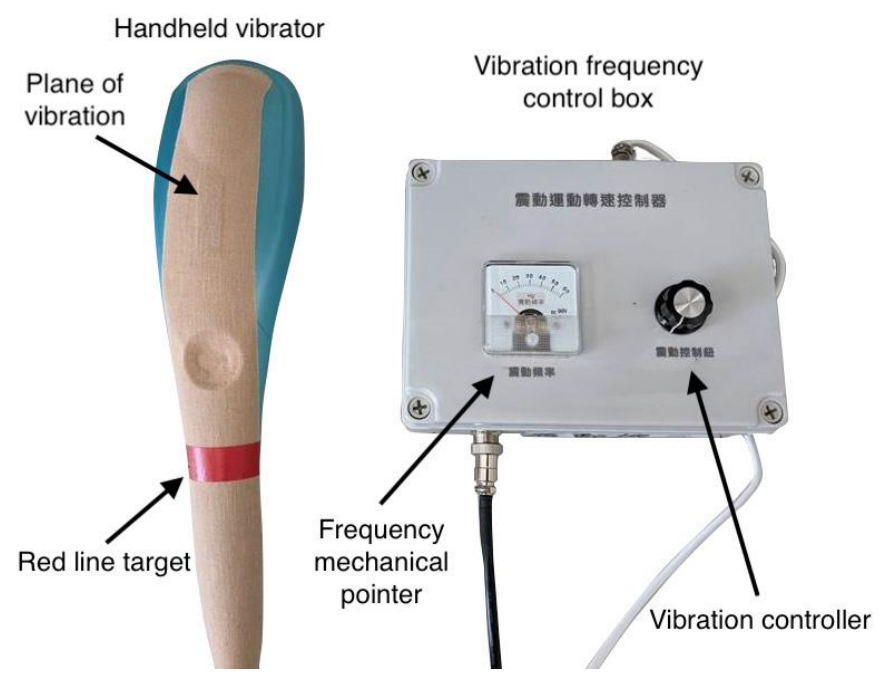
Figure 1. Handheld vibrator and related component parts.